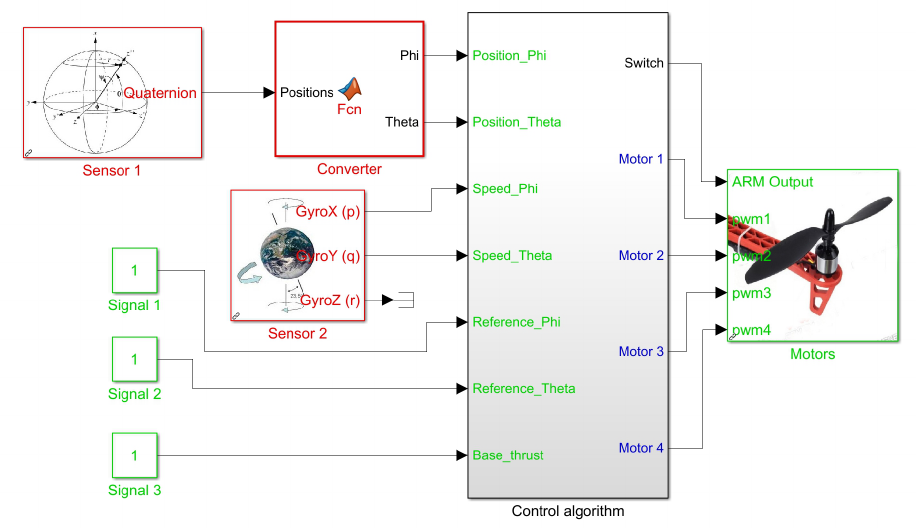
Figure 15. Simulink block diagram for state feedback controller